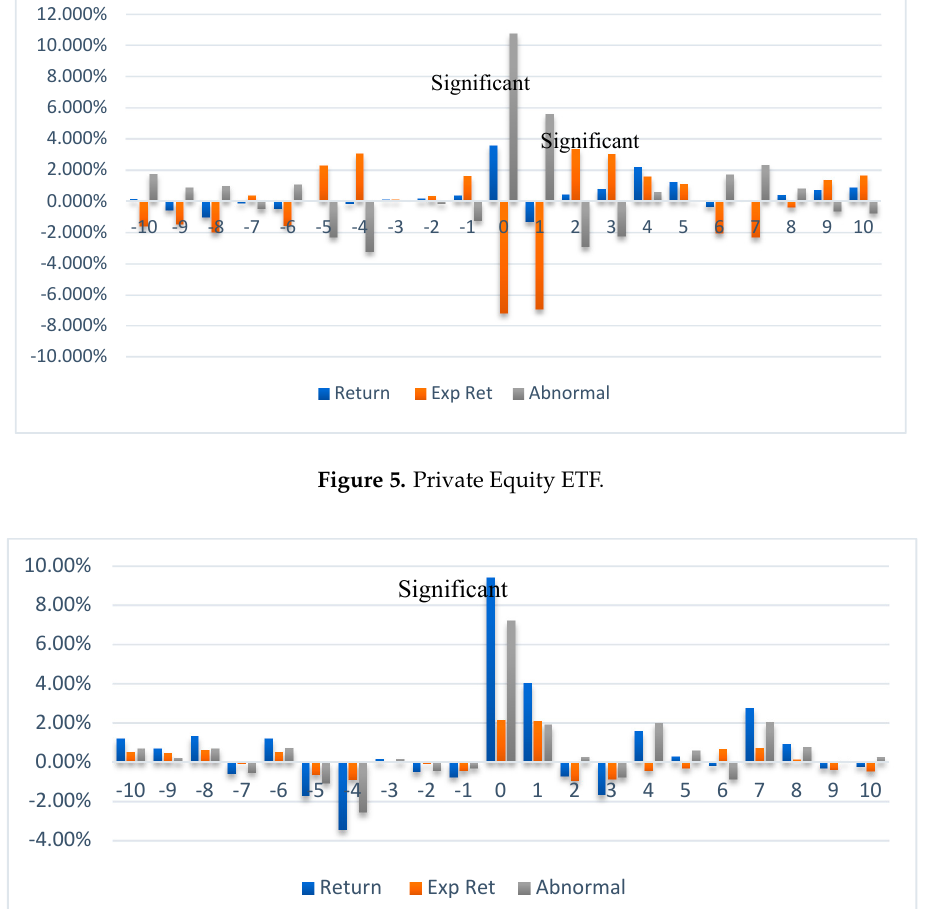
Figure 6. US T-Bond ETF.